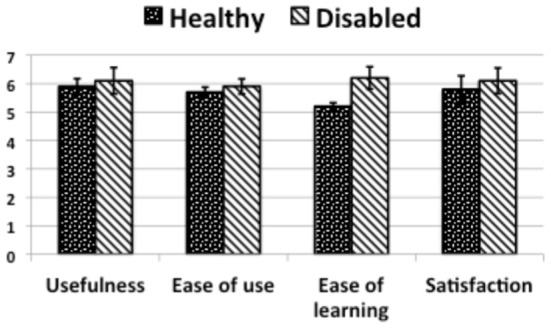
A bar chart summarizing the median answers of the user for each question category across Experiment 1 and 2. The error bars are the 95% bootstrapping confidence intervals.